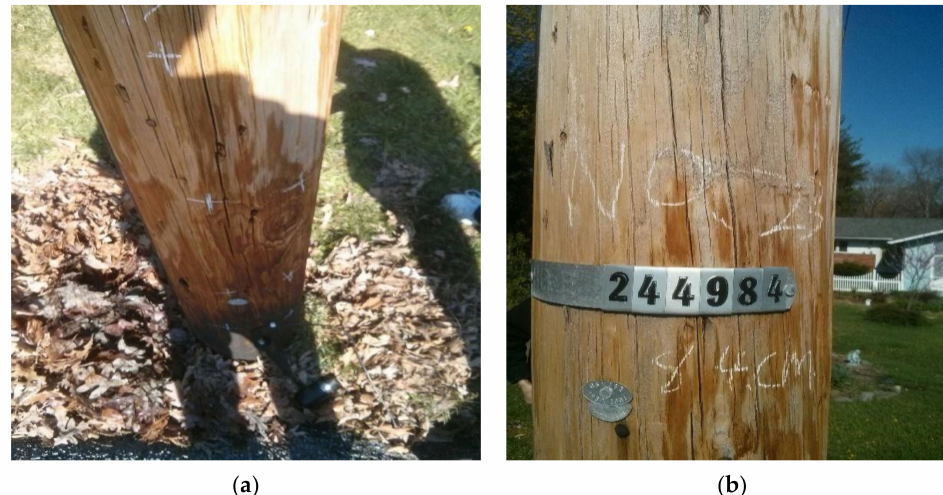
Figure 10. Tested wooden utility pole labeled as 244984: ( a ) its embedment condition and ( b ) its label.